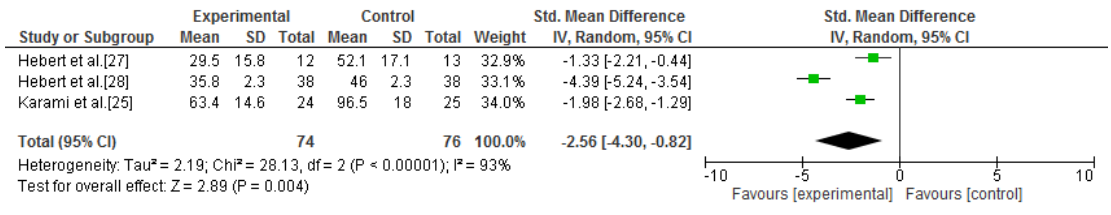
Figure 6. Forest plot of the meta-analysis of fatigue (vestibular rehabilitation versus no intervention).